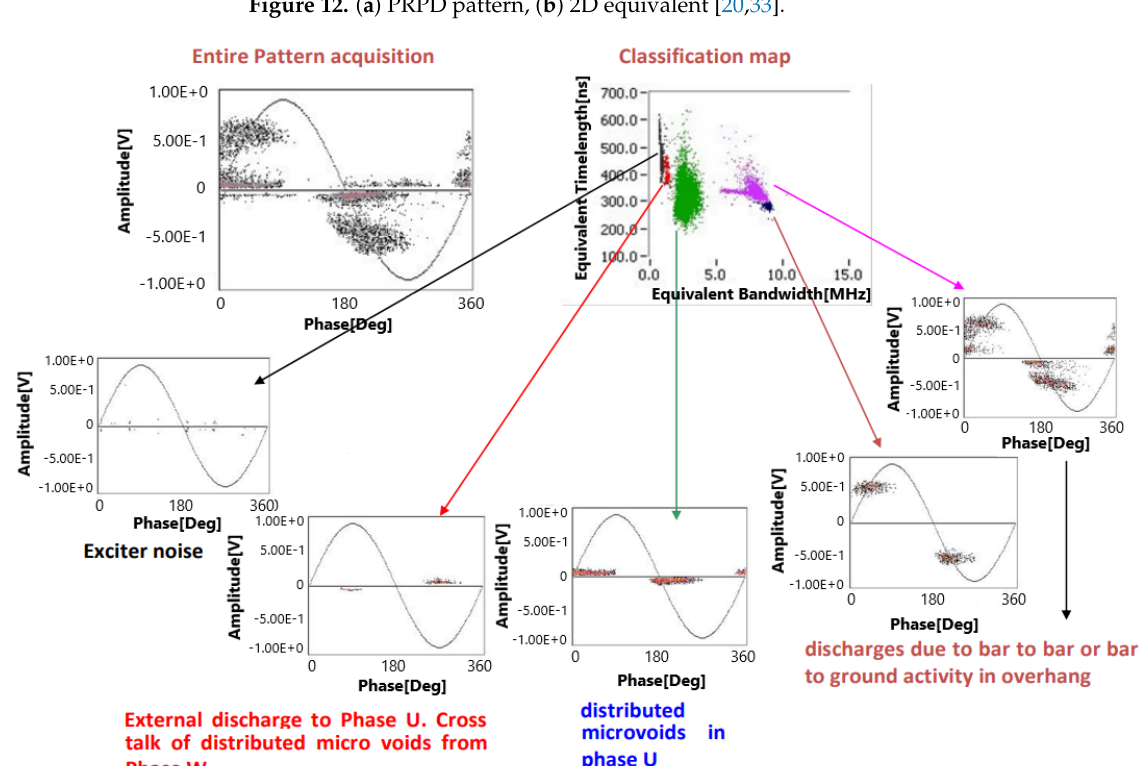
Figure 13. T-F map